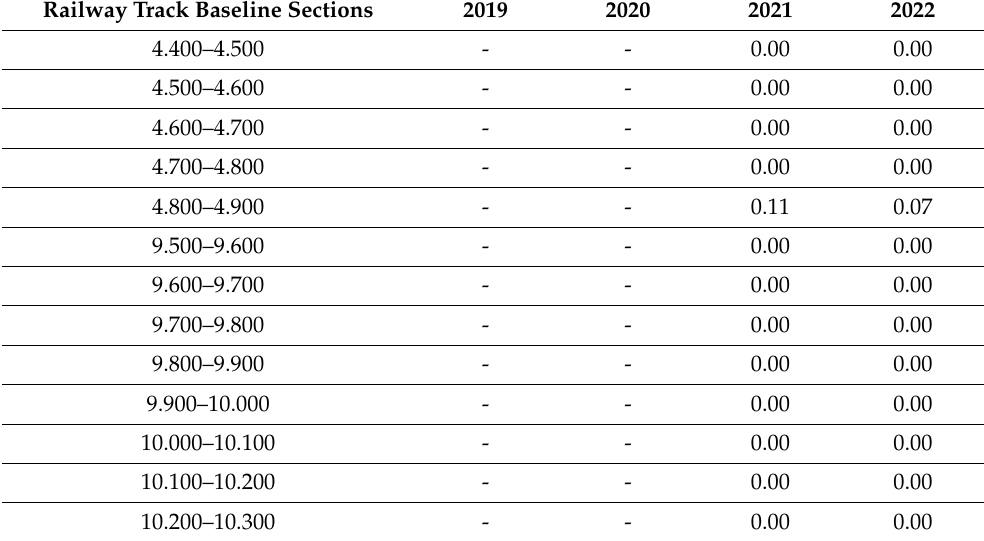
Table A14. Estimates of the railway track condition—relative D 6 , object No. R 161_1.